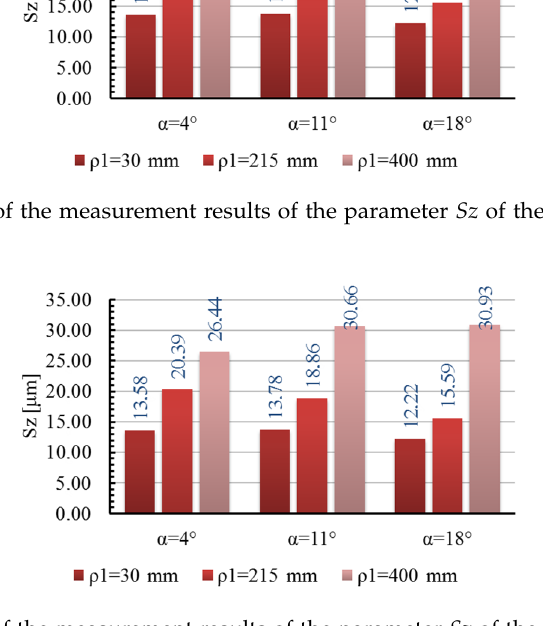
Figure 23. Statement of the measurement results of the parameter Sz of the concave surface of the turbine blade.